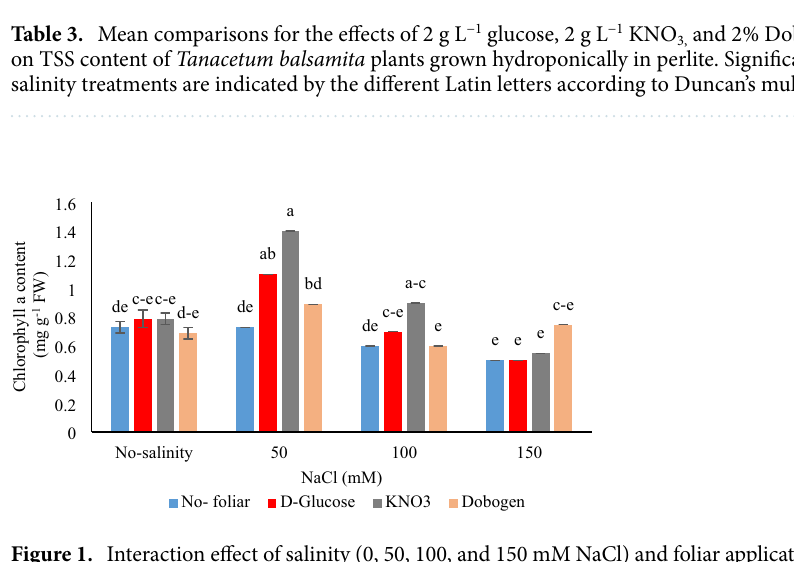
Figure 1. Interaction effect of salinity (0, 50, 100, and 150 mM NaCl) and foliar applications (no-foliar, 2 g L −1 glucose, 2 g L −1 KNO 3, and 2% Dobogen biostimulant) on the chlorophyll a content of Tanacetum balsamita plants grown in perlite. Significant differences among treatments are indicated by the different Latin letters according to Duncan’s multiple range